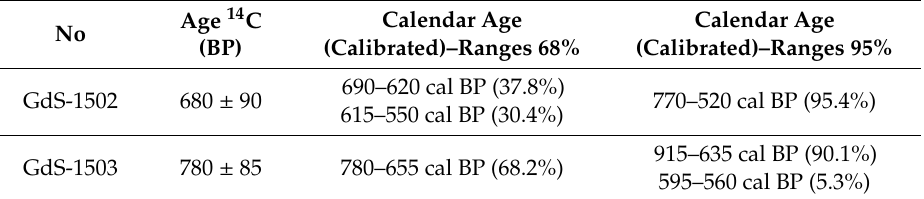
Figure 8. Landforms evolution in the light of fossil organic deposits dating. Table 4. Dating of the fossil tundra from a push moraine layer.